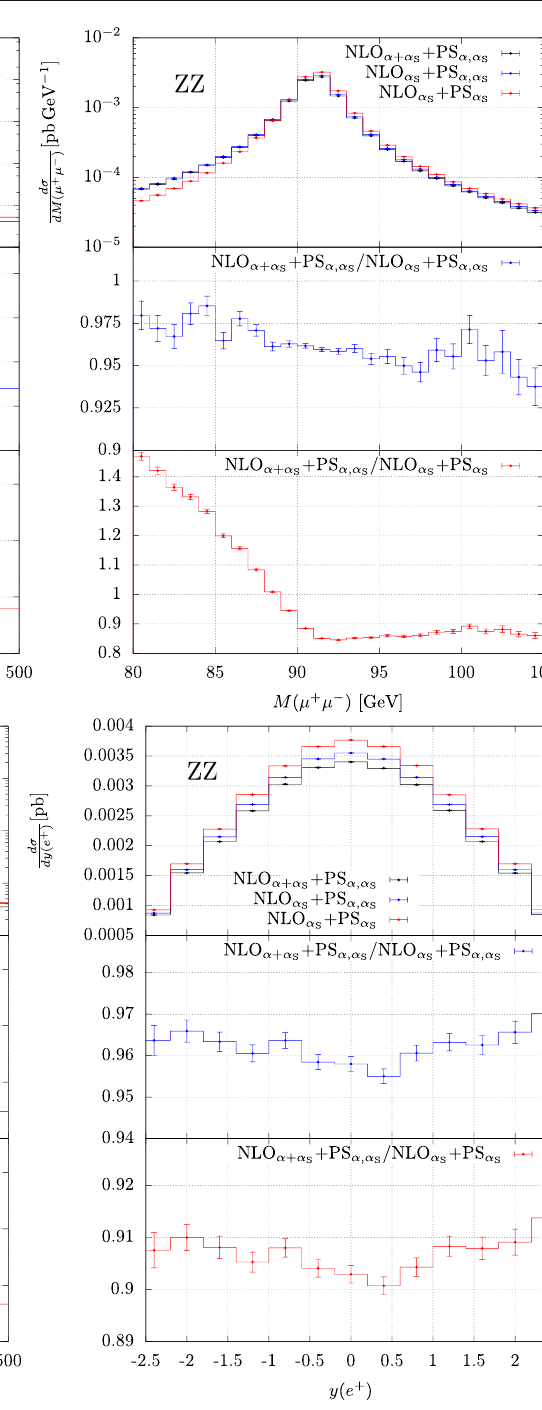
Fig. 4 Comparison of the predictions at NLO QCD + NLO EW of the hardest Z (bottom left), and of the positron rapidity (bottom right). Central panels: ratio of the predictions at NLO QCD + NLO EW + + PS QCD , QED (NLO α + α + PS α,α ), at NLO QCD + PS QCD , QED S S PS QCD , QED and at NLO QCD + PS QCD , QED . Lower panels: ratio of the (NLO α +PS α,α ), and at NLO QCD + PS QCD (NLO α + PS α ) accuracy S S S S for the process pp → μ + μ − e − e + . Upper panels: differential distri- results at NLO QCD + NLO EW + PS QCD , QED and at NLO QCD + PS QCD . butions as a function of the positron transverse momentum (top left), See main text for of the dimuon invariant mass (top right), of the transverse momentum